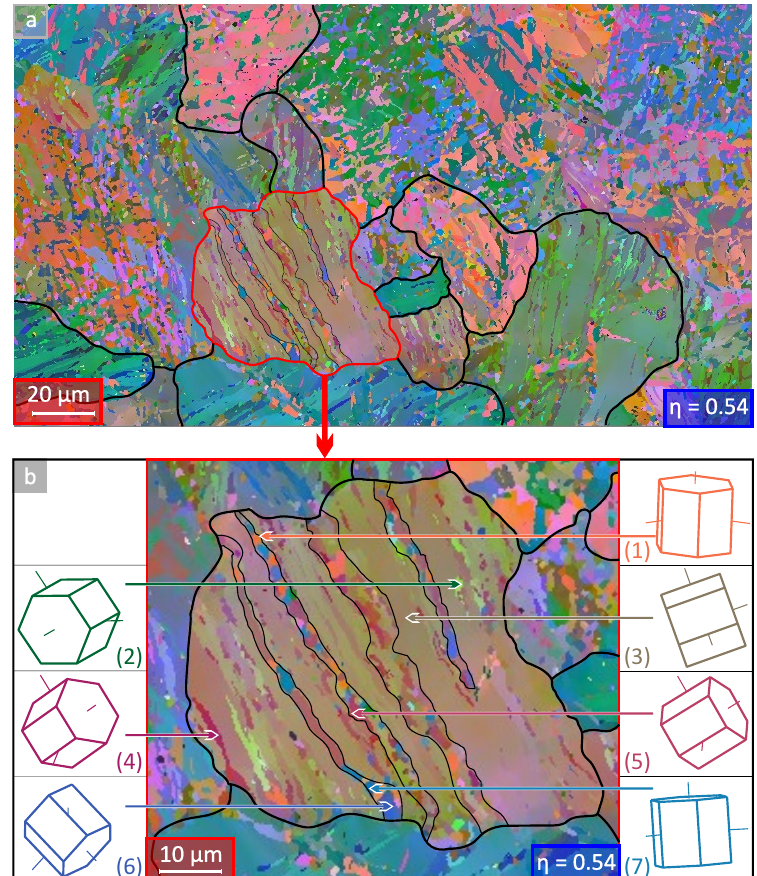
Figure 7. Orientation maps (SEM-EBSD) of AZ31 after cold rotary swaging to true strain of 0.54 with magnified image of a initial grain (highlighted in red). The orientation of the initial grain is represented by (3). Orientations (4) and (5) related to (3) corresponds to { ¯ 1012 } and { ¯ 1011 } twins,